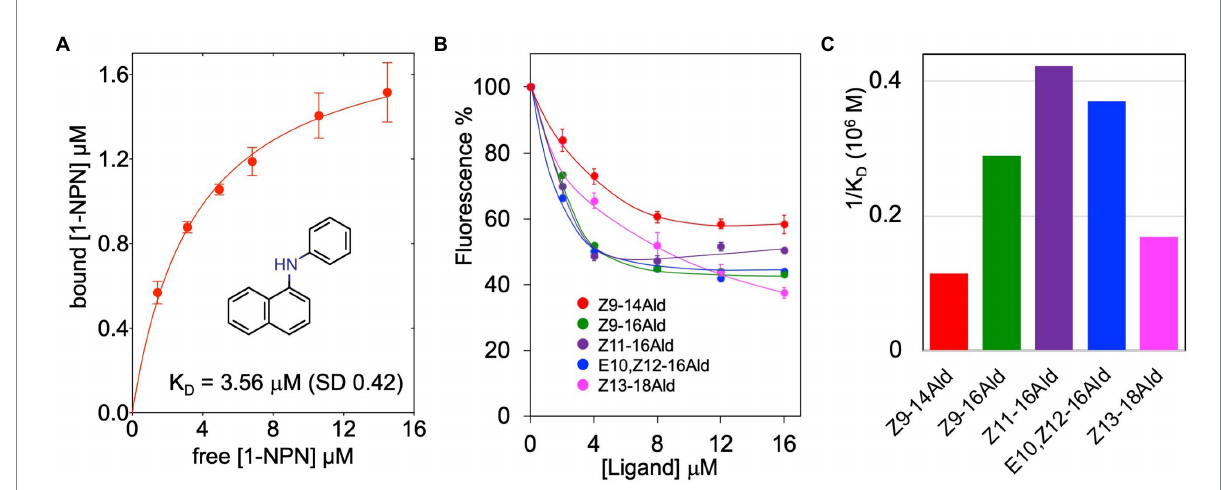
FIGURE 4 Ligand-binding properties of LafrOBP2. (A) Binding of the fluorescent reporter N -phenyl-1-naphthylamine (1-NPN) to recombinant LafrOBP2. A 2 μ M solution of the protein in 50 mM Tris–HCl buffer, 1 M NaCl, pH 7.4, was titrated with aliquots of 1 mM 1-NPN in methanol. The probe was excited at 337 nm, and emission intensities were recorded at 420 nm. Measurements were performed in triplicates and standard deviations are reported. Data were analysed with GraphPad Prism software. (B) Competitive binding curves of selected long-chain aldehydes to LafrOBP2. Aliquots of 1 mM of each ligand in methanol were added to mixtures of the protein and 1-NPN, both at the concentration of 2 μ M. Measurements were performed in triplicates and standard deviations are reported only for selected ligands to avoid overlapping of the bars. The protein is narrowly tuned to unsaturated linear C16-aldehydes. The relative dissociation constants are graphically compared in panel (C) . Displacement curves for other chemicals, which showed some affinity for the protein are reported in Supplementary Figure S2. All ligands used in the study are listed in Table 1 with their binding